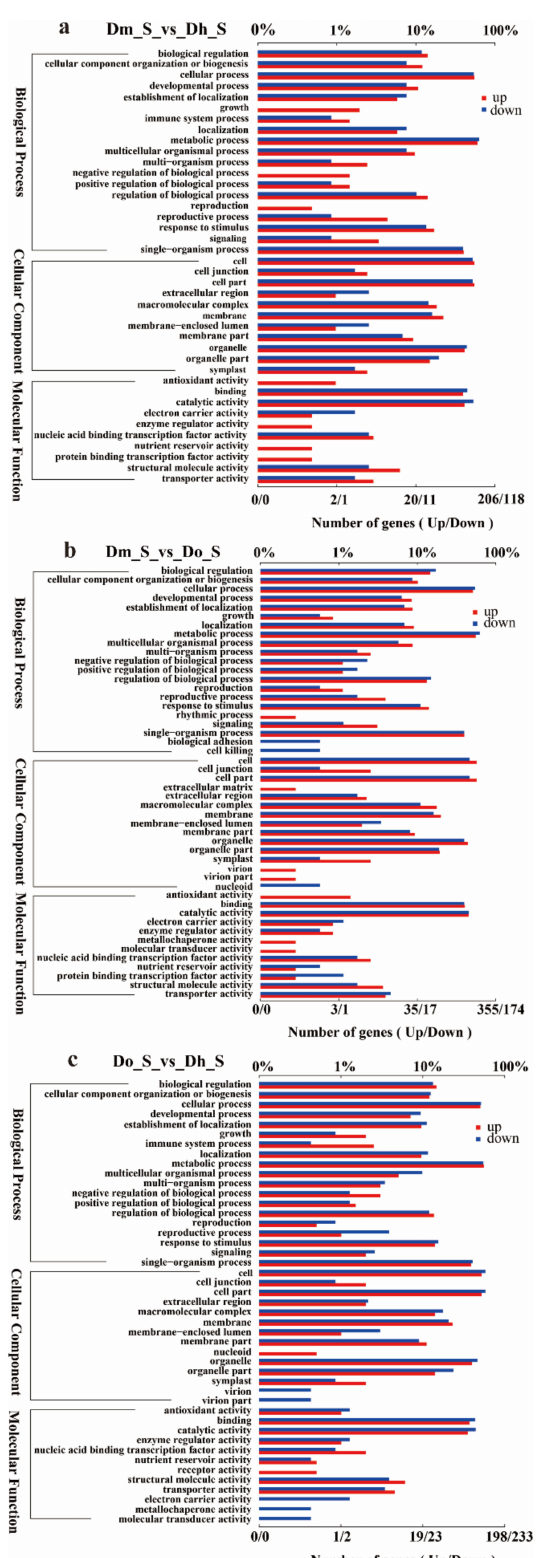
Figure 5. Gene Ontology (GO) annotations of up and down regulated DEGs. The bottom x-axis indicates the number of DEGs annotated to a GO term, the upper x-axis indicates the proportion of DEGs annotated to a GO terms to the total number of all GO annotated DEGs; and the y-axis represents each detailed classification of GO. ( a ) Dm_S vs Dh_S GO annotation; ( b ) Dm_S vs. Do_S GO annotation; ( c ) Do_S vs. Dh_S GO